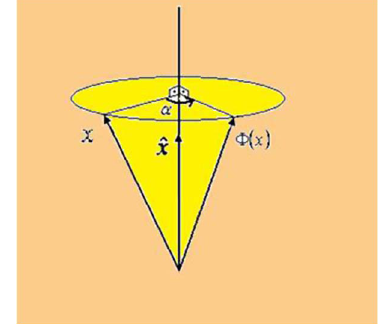
Figure 1. A counterclockwise rotation through an angle a about an axis ^ x in R 3